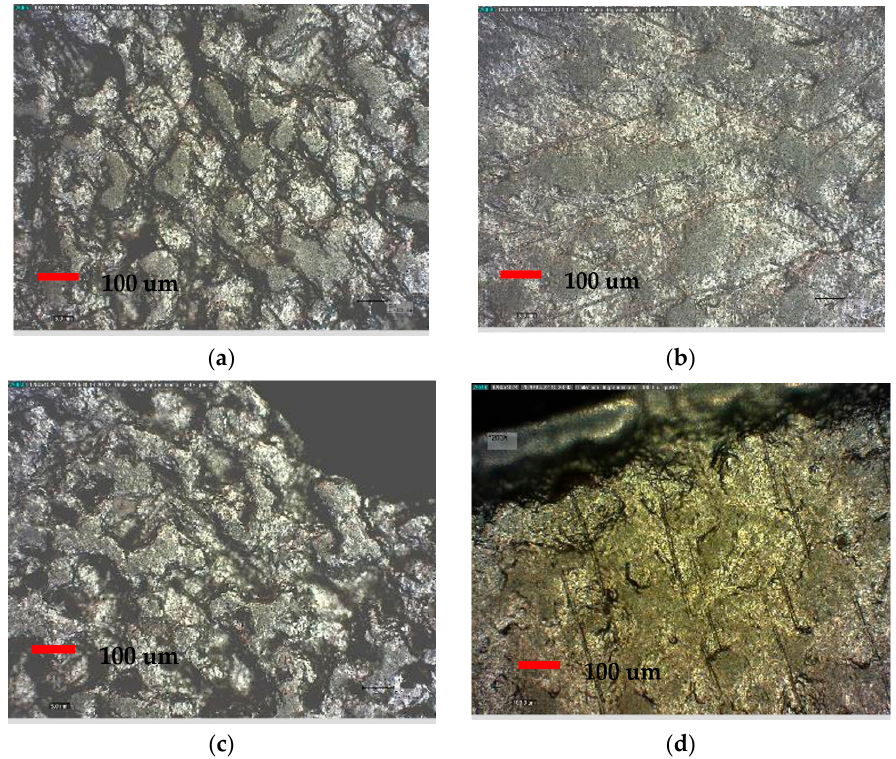
Figure 4. A 200× optical microscopy analysis: ( a , b ) on specimens exposed at pH 7 for 21 days, ( c , d ) on specimens exposed at pH 4 for 21 days. No macroscopic differences can be seen.